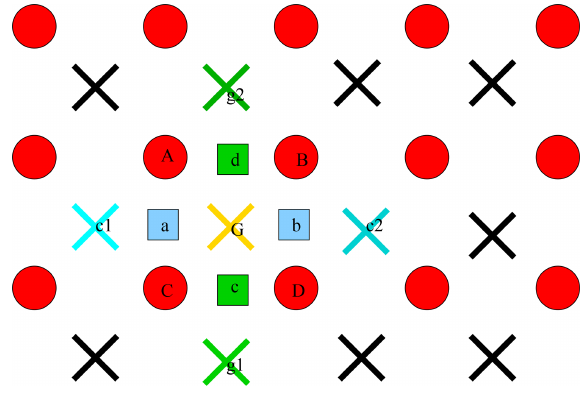
Figure 1. Schematic representation showing the horizontal advec- tion scheme staggering for a scalar variable. Circles are U , V points. Crosses (X) represent scalar variable points. Squares (identifying points a,b,c,d) are points where weighted averages are calculated for variables contributing to advection on point